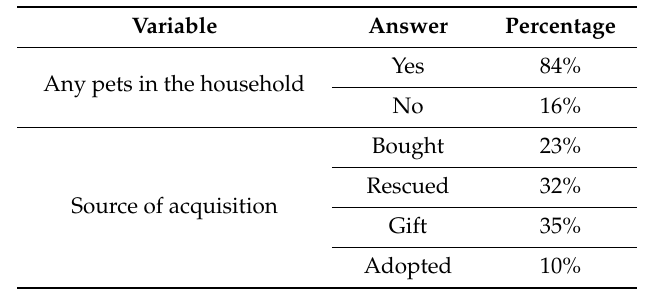
Table 2. General pet